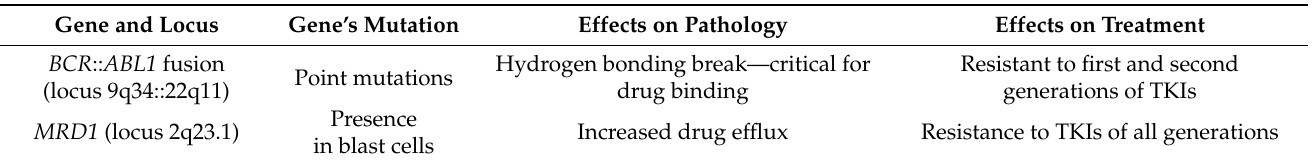
Table 7. Characteristics of genes associated with treatment resistance in patients with the Philadelphia